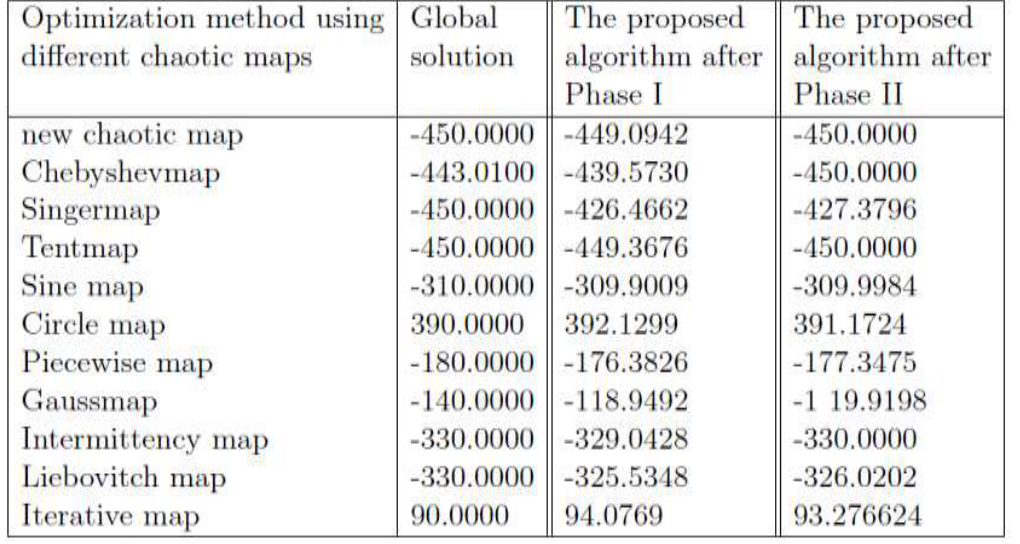
Figure 5. The first row represents the iteration of the fixed points of Eq. (7) while, the second row indicates the Bifurcation diagram, which is zoomed in the iteration 300 through 450 for the value of r=1.1, and x Followed by the invariant density ρ=0.005, the perpetrate trajectories and the last plot is the Lyapunov exponent λ=-0.105. Therefore, the system is stable after one iteration. Table 1. Comparison of chaotic genomic algorithm solution and outcome prior to